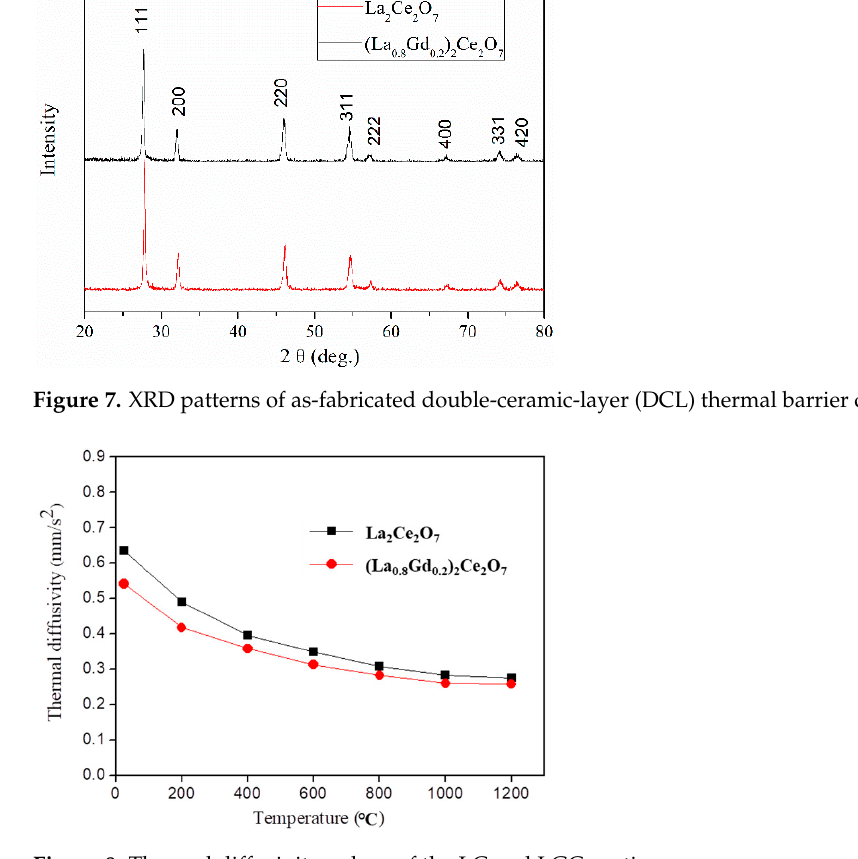
Figure 8. Thermal diffusivity values of the LC and LGC coatings.